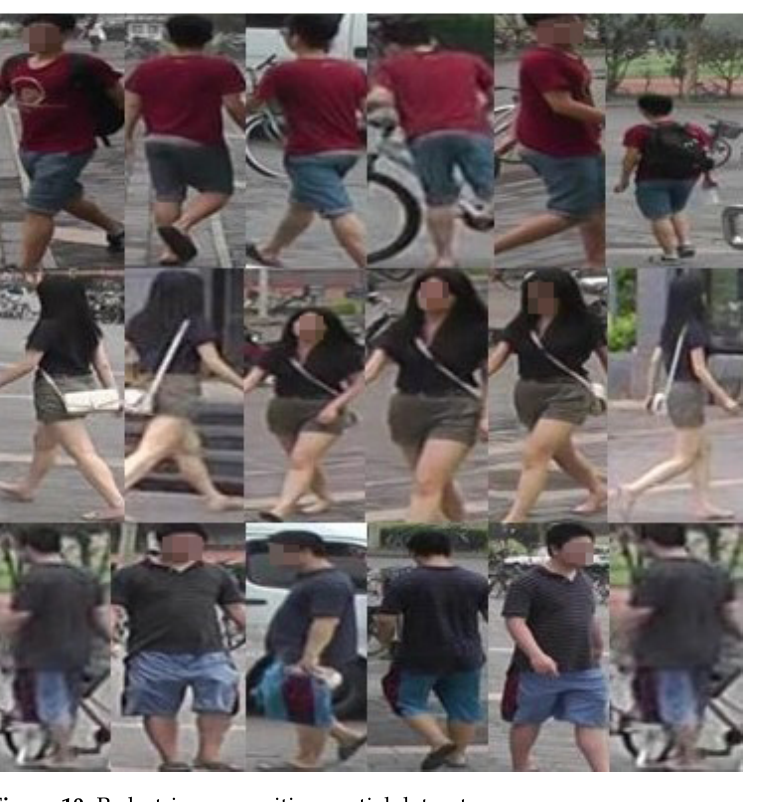
Figure 10. Pedestrian recognition partial dataset.